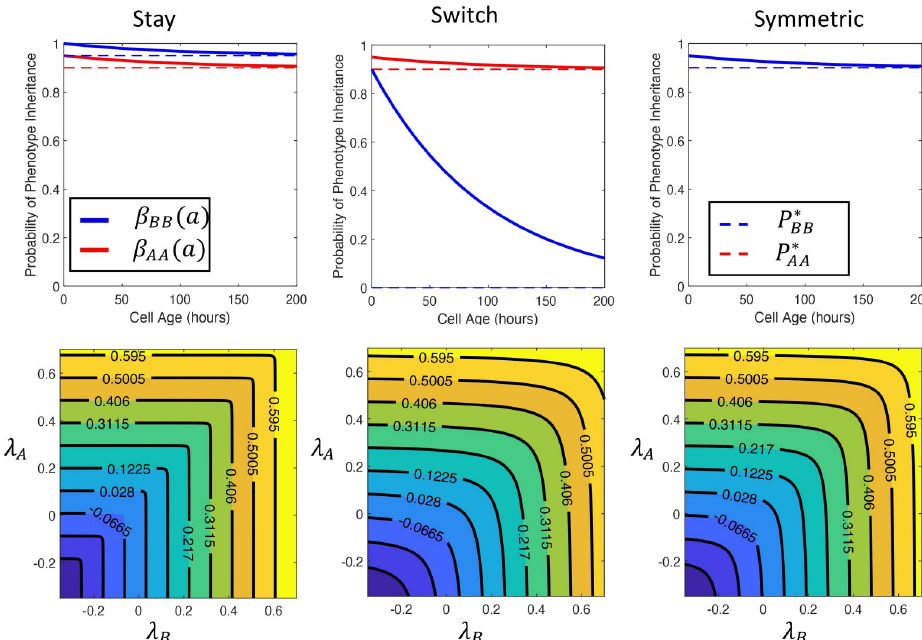
Fig 2. Switching strategies and the Malthusian parameter λ P as a function of the intrinsic growth rates of sensitive and tolerant cells. The three switching strategies for the drug-tolerant population are the stay strategy ð P � ; P max Þ ¼ ð 0 : 95 ; 1 Þ , the switching strategy ð P � ; P max Þ ¼ ð 0 ; 0 : 9 Þ , and the symmetric strategy BB BB BB BB ð P � ; P max Þ ¼ ð 0 : 9 ; 0 : 95 Þ . In all cases, we fixed ð P � ; P max Þ ¼ ð 0 : 9 ; 0 : 95 Þ and σ = σ = 1 × 10 − 2 . The probabilities A B BB BB AA AA β AA ( a ) and β BB ( a ) for each strategy are shown in the top row. We calculated the Malthusian parameter λ P as detailed in the section Nonlinear eigenproblem for the Malthusian parameter in S1 Text and plot the intrinsic growth rate of the mixed population as a function of the intrinsic growth rates of the constituent populations in the second row. The growth rate of the population is increasing along the main diagonal in all cases and the isoclines plot curves of equal population level fitness. In the stay strategy, the isoclines are shorter in λ than in λ which indicates that λ is more B A P sensitive to changes in fitness of the tolerant population, λ B . Conversely, in the switch strategy, the isoclines indicate that λ is more sensitive to λ . Finally, the Malthusian parameter is symmetric along the main diagonal in the P A symmetric strategy which indicates that fitness of the tolerant or sensitive phenotype equally impacts mixed population